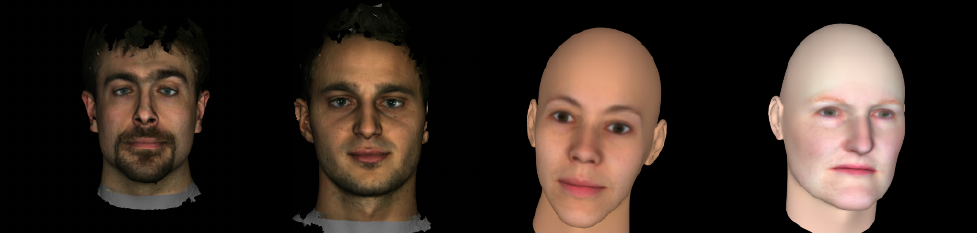
Figure 20. Random images from MICC Florence and FaceGen datasets. The two images on the left are from MICC Florence and the two images on the right are from